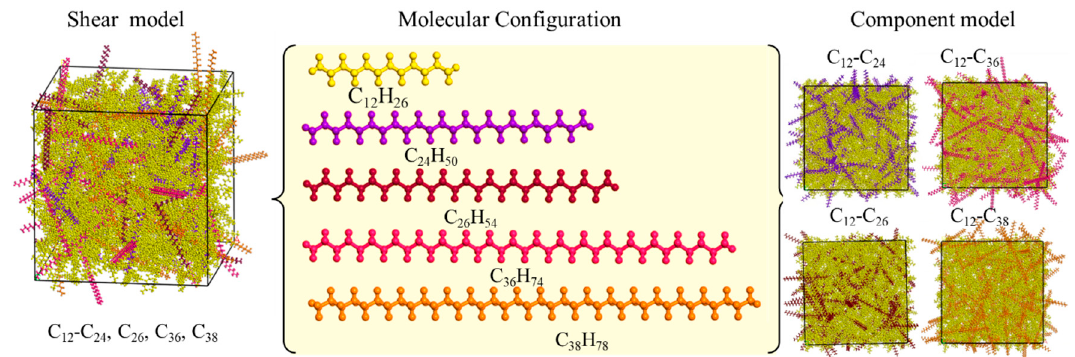
Figure 1. Molecular composition and model.